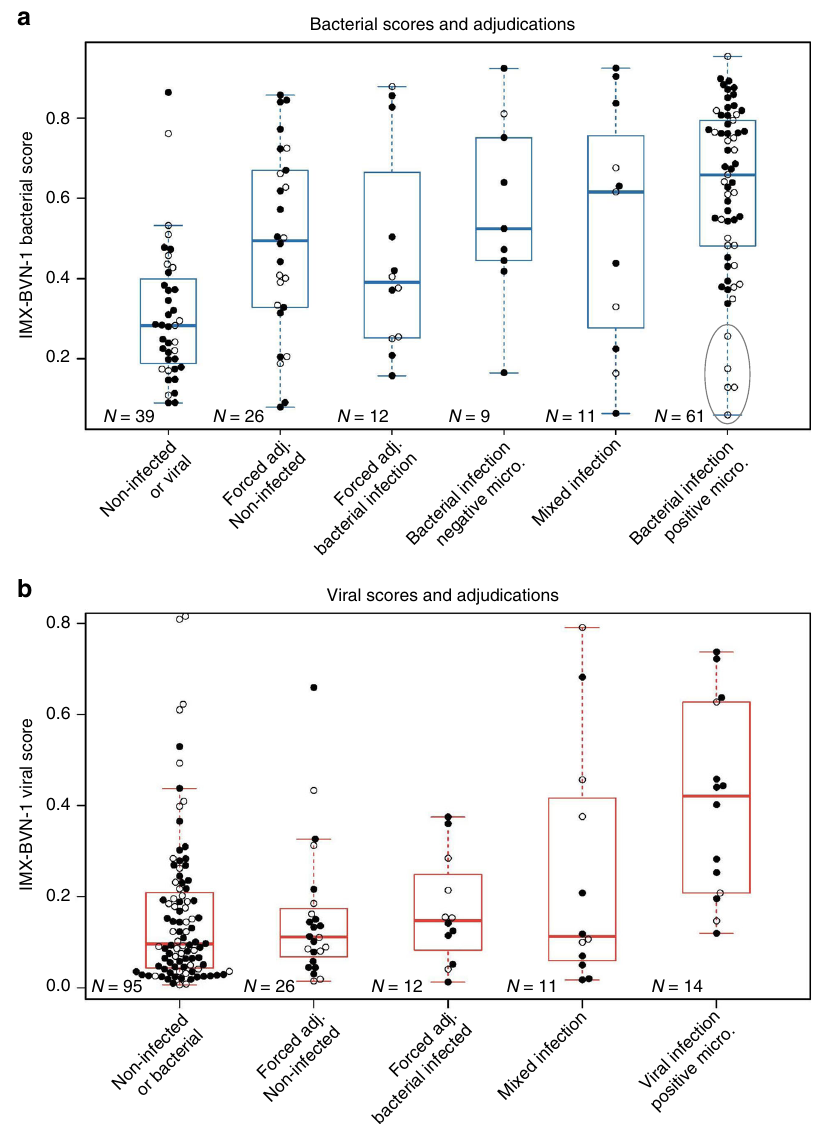
Fig. 3 IMX-BVN-1 predicted probabilities in the Stanford ICU cohort across all clinical adjudication outcomes for bacterial and viral infections. The gray oval in ( a ) highlights a small number of patients with low bacterial scores, all of whom received antibiotics and were admitted >36 h prior to enrollment. X -axis categories indicate adjudicated infection status. Open circles indicate admission timing (black/closed ≤ 36 h, white/open >36 h). For each boxplot, the box shows the median and 25 th – 75 th quartile range (IQR), and the whiskers extend to the most extreme data point no further from the box than 1.5 times the IQR. Adj., adjudication; Micro.,